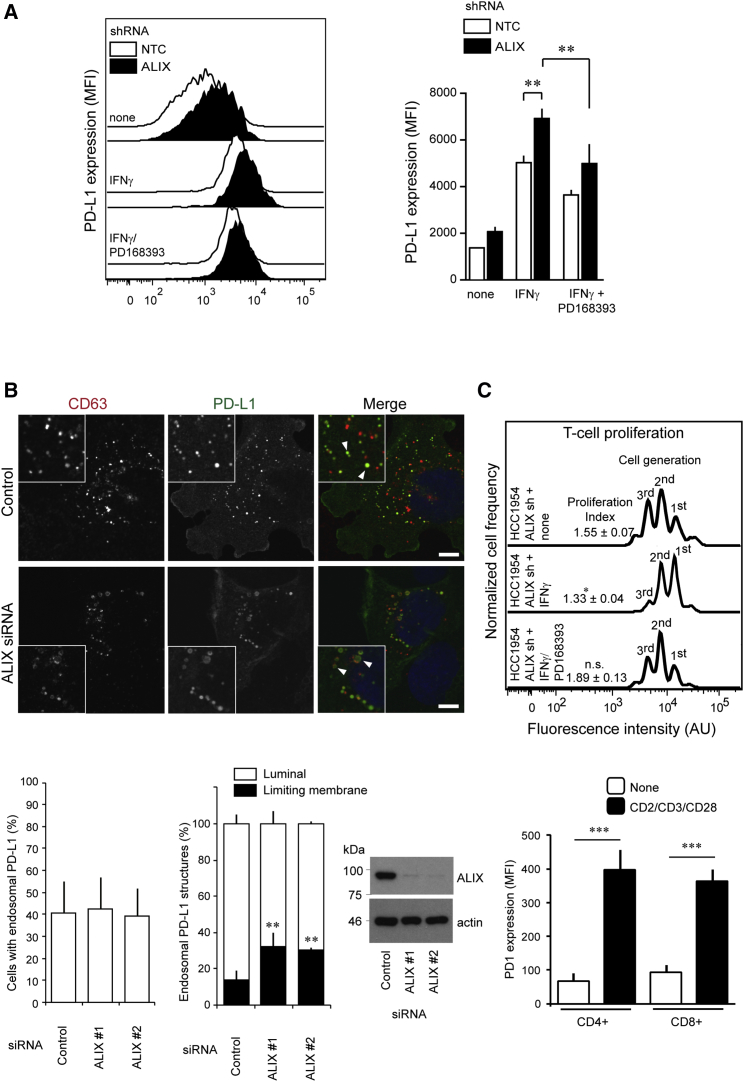
ALIX Regulates the Immunosuppressive Properties of HCC1954 Cells via a Redistribution of PD-L1(A) Flow cytometry data and statistical analysis of surface PD-L1 expression in NTC and ALIX KD HCC1954 cells. Bars represent mean fluorescence intensities ± SEM (∗∗p < 0.01, ANOVA).(B) Top: HCC1954 cells were transfected with indicated siRNAs, treated with IFNγ, fixed, stained using antibodies against endogenous CD63 and PD-L1, and counterstained with DAPI. The percentage of cells displaying endosomal PD-L1 was calculated (bottom left graph, mean ± SD), and the percentages of CD63-positive PD-L1 decorated structures were scored: control, 63 ± 4.2%; ALIX #1, 64 ± 4.7%, n.s. (not significant); ALIX #2, 59 ± 2.7%, n.s. 100 cells per experiment, n = 4. Intraendosomal PD-L1 localization (right graph), was also scored; 3,977 endosomes from 10 fields of view per experiment were scored over 4 independent experiments (mean ± SD, ∗∗p < 0.01, two-tailed Student’s t test). Lysates were examined by western blotting. Arrowheads highlight luminal and limiting membrane accumulation of PD-L1 in MVBs of control and ALIX KD cells, respectively. Scale bars, 10 μm.(C) Cell-tracker dye intensity histograms of CD8+ T cell proliferation from labeled T cell-tumor cell co-culture assays. Cell proliferation indices are shown for each treatment group with their associated SEM (∗p < 0.05 versus control group; n: 5 independent experiments for each treatment group). Bar chart summarizes the flow cytometry data of surface PD-1 expression in naive and CD2-, CD3-, and CD28-stimulated CD4+ and CD8+ T cell subpopulations (∗∗∗p < 0.001, Student’s t test; data are from n = 5 independent experiments).See also Figures S5 and S6.